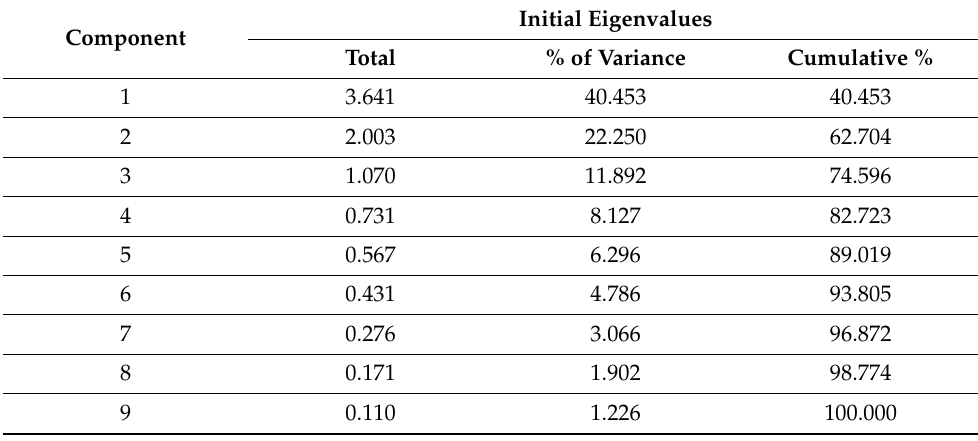
Table 3. Eigenvalues and total variance.